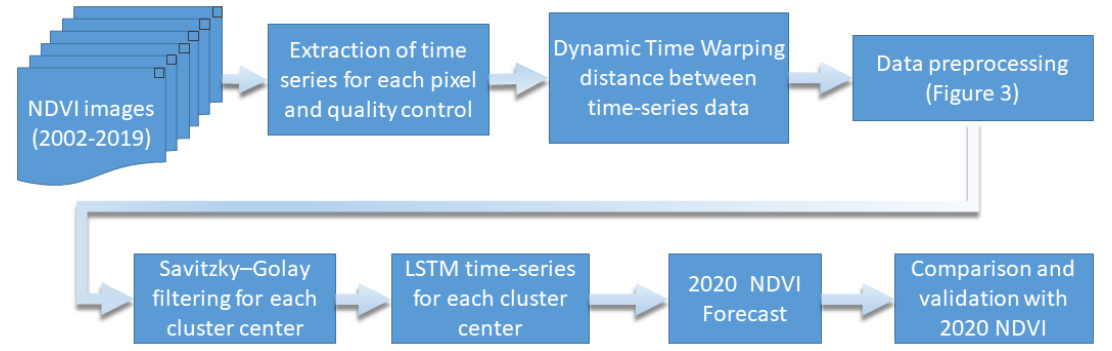
Figure 5. Methodology of the normalized difference vegetation index (NDVI) 12 – month forecast based on long short-term memory (LSTM) neural networks.